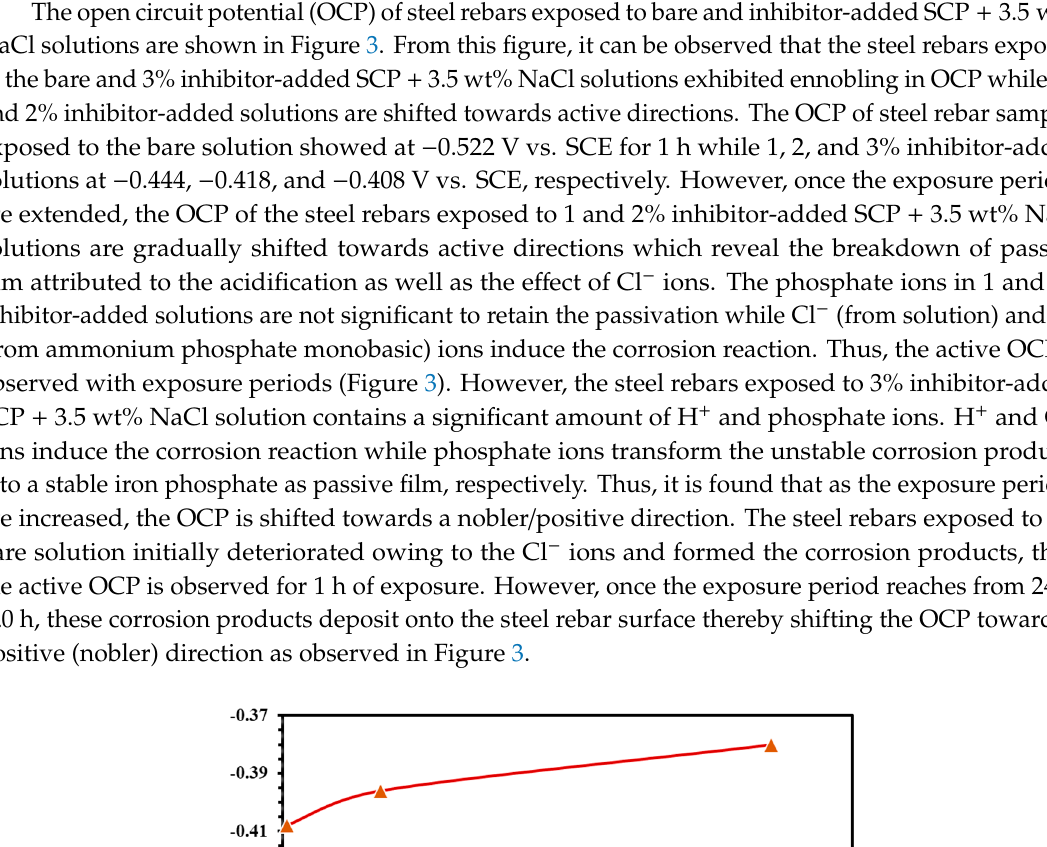
Table 2. Adsorption parameters of inhibitor.